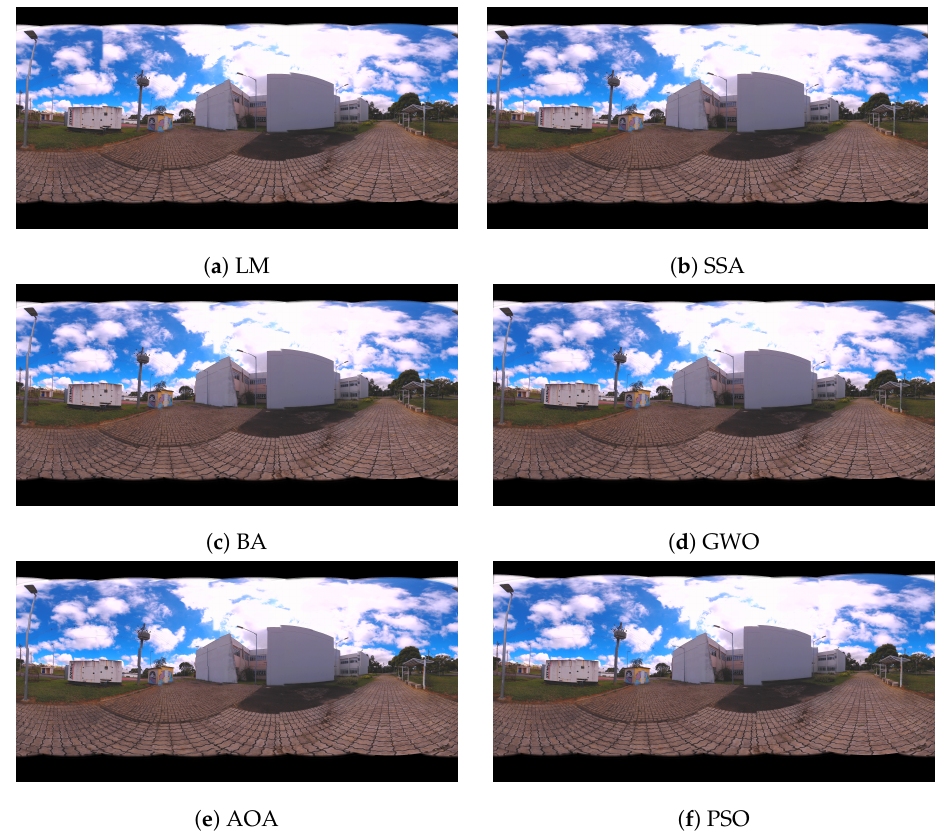
Figure 16. 360 Panoramic Images Resulting from the Proposed Metaheuristics for Case Study II: ( a ) Levenberg–Marquardt (LM), ( b ) Salp Swarm Algorithm (SSA), ( c ) Bat Algorithm (BA), ( d ) Grey Wolf Optimizer (GWO), ( e ) Arithmetic Optimization Algorithm (AOA) and ( f ) Particle Swarm Optimization (PSO).